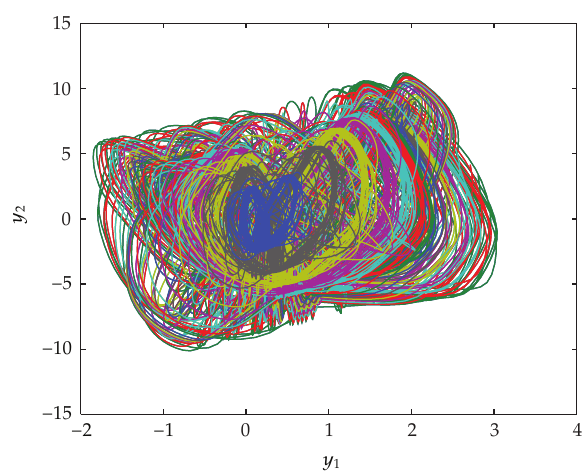
Figure 3: Chaotic behavior of system (cid:6) 4.1 (cid:7) .